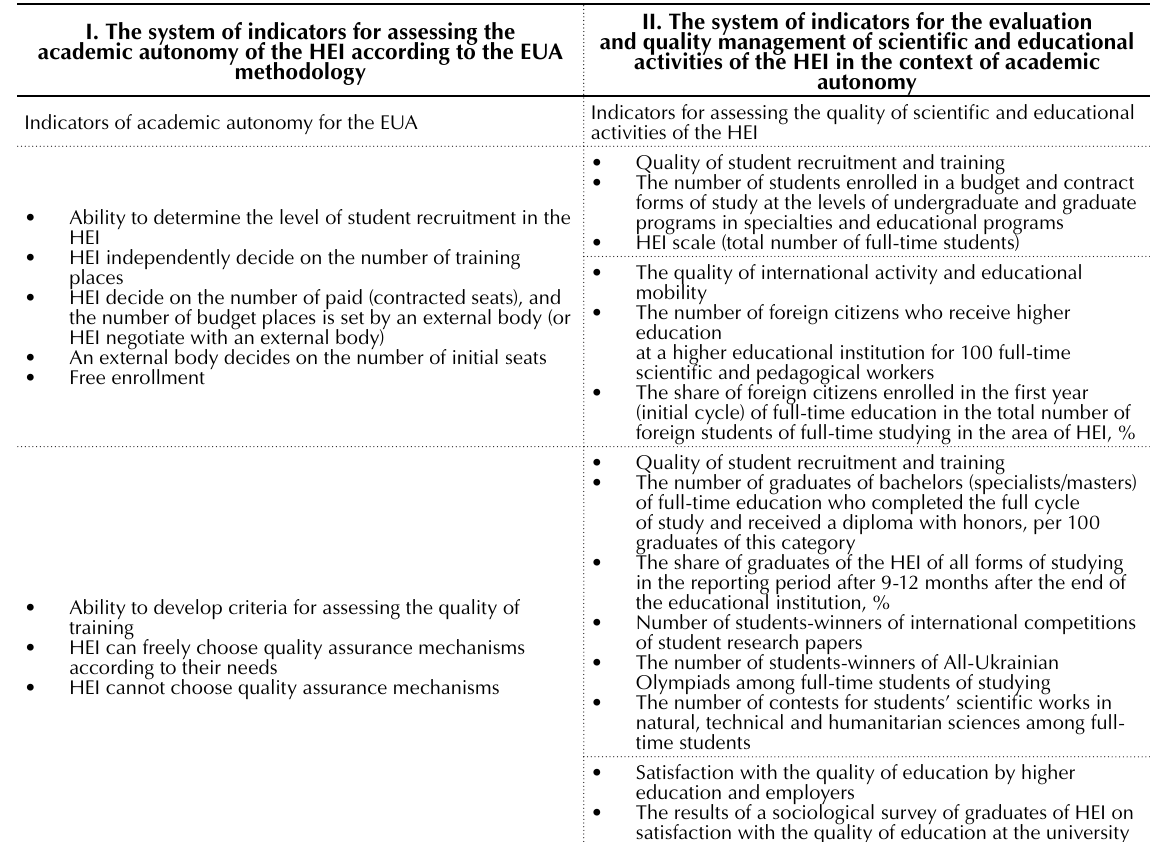
Table 2. Harmonized indicator systems for assessing academic autonomy and quality level of scientific and educational activities of HEI